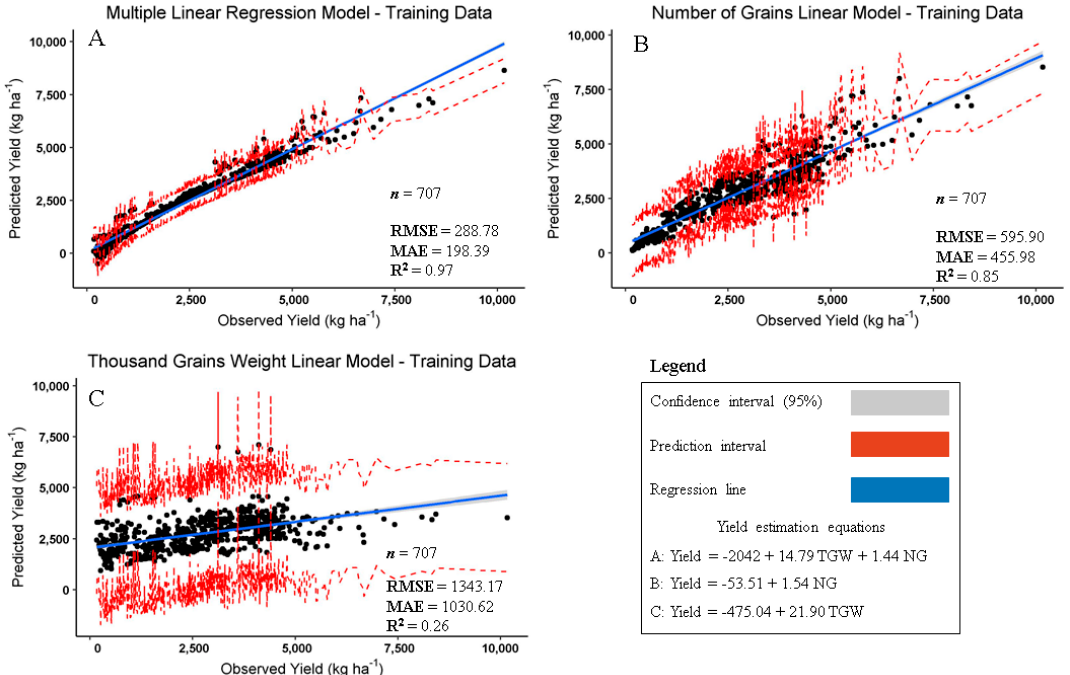
Figure 2. Scatterplot of soybean observed and predicted yields (kg ha − 1 ) applied to training dataset. ( A ) Yield estimation based on thousand grains weight (TGW in g 1000 grains − 1 ) and number of grains (NG in grain m − 2 ), ( B ) yield estimation as function of number of grains (NG in grains m − 2 ) and ( C ) yield estimation as functions of thousand grains weight (TGW in g 1000 grains − 1 ). n = number of observations; MAE = mean absolute error (kg ha − 1 ); RMSE = root mean squared error (kg ha − 1 ); R 2 = multiple R-squared; Yield = soybean yield (kg ha − 1 ); TGW = thousand grains weight (g 1000 grains − 1 ); NG = number of grains (grains m − 2 ).